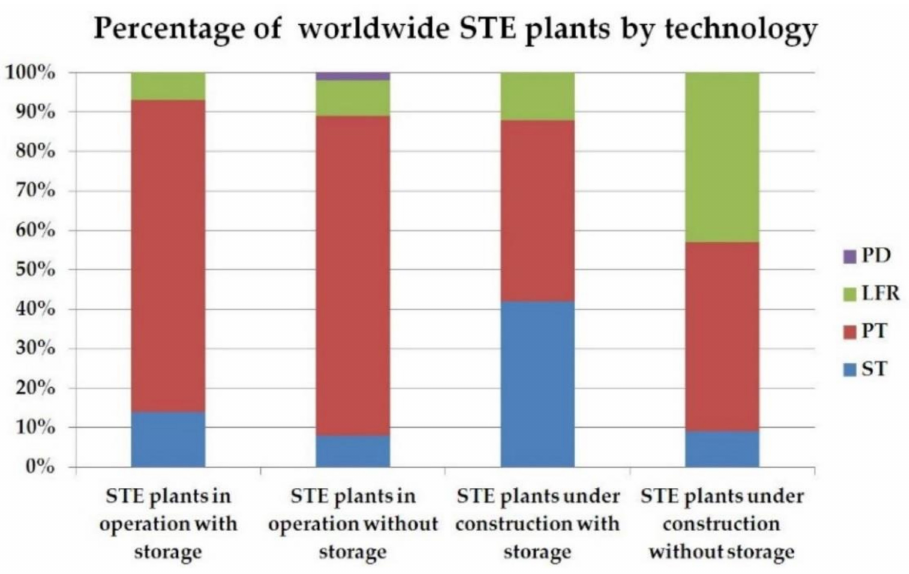
Figure 9. STE worldwide capacity categorized by technology and with/without storage